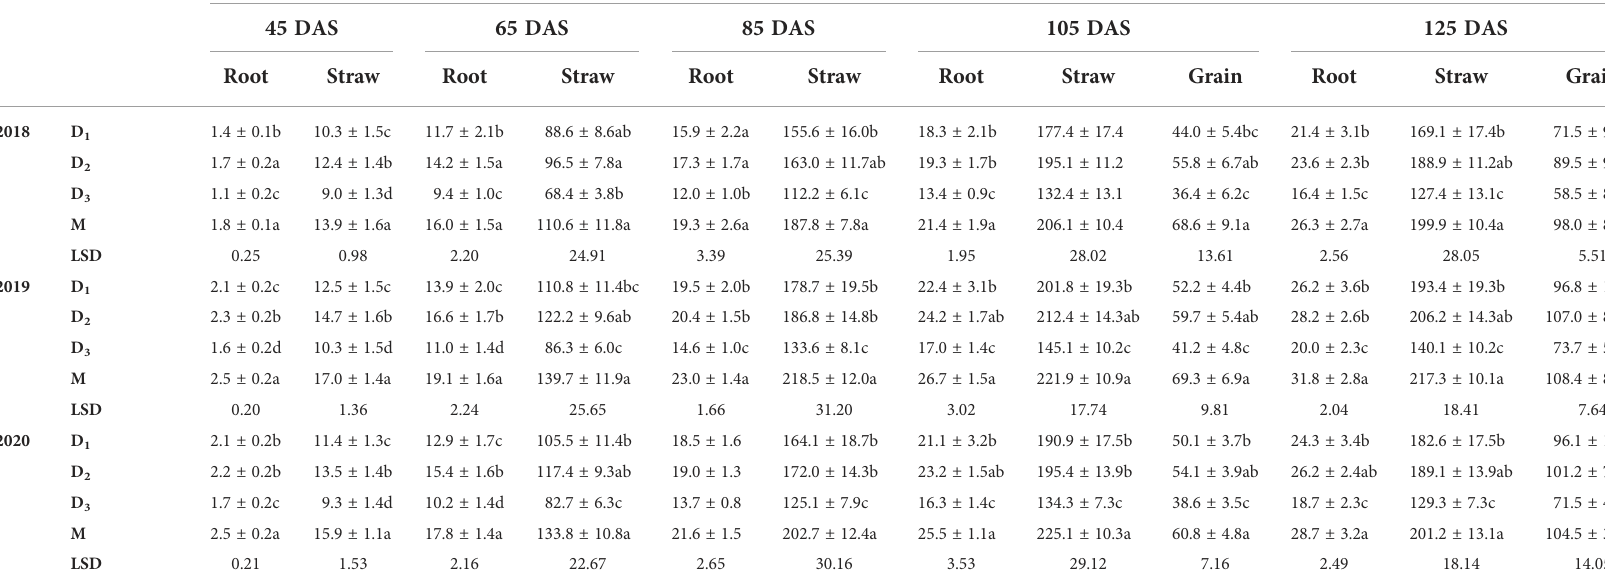
TABLE 4 Dry matter partitioning in different plant parts of maize at 45, 65, 85, 105, and 125 days after sowing (DAS) under different maize/soybean strip intercropping treatments and sole cropping of maize.